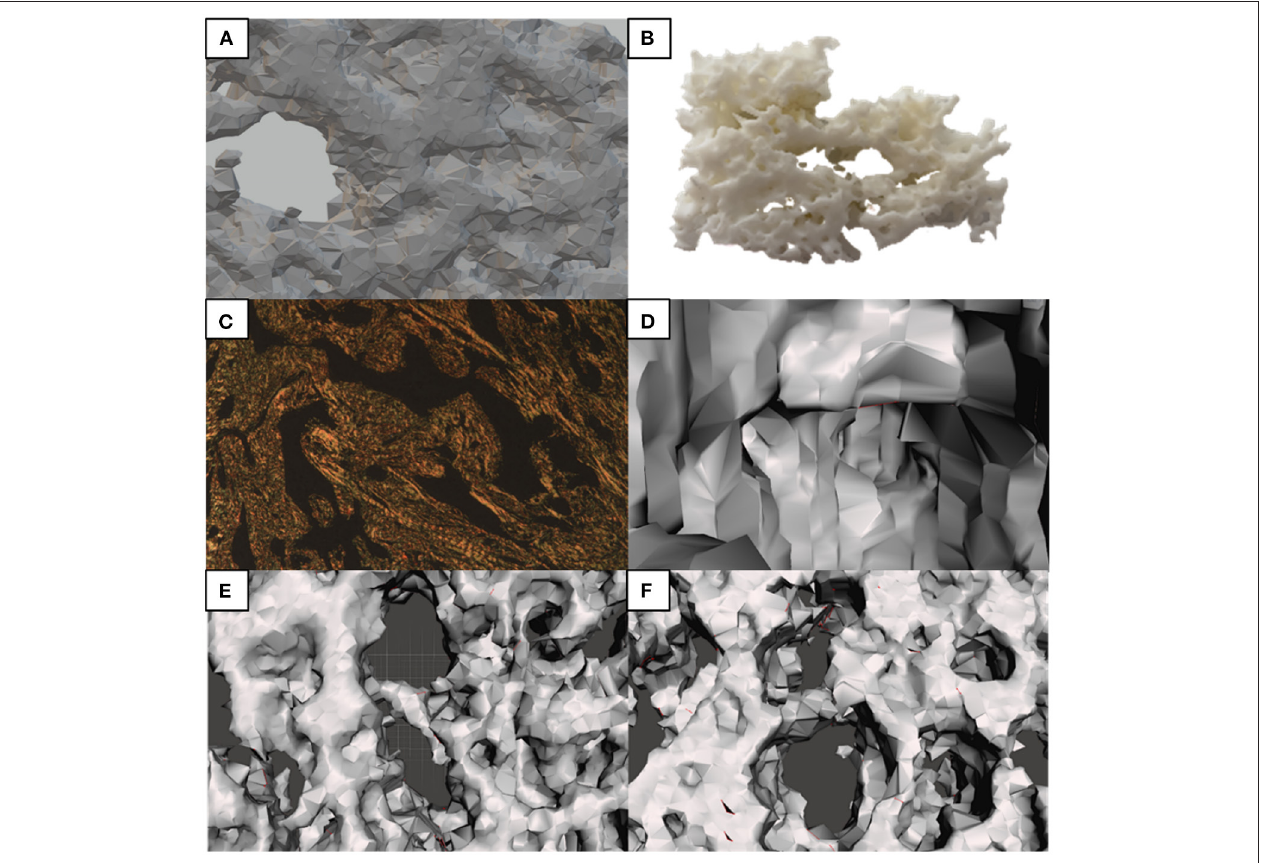
FIGURE 4 | Morphological characteristics observed under conventional microscopy and identified in the 3D model. (A) Simplified 3D model; (B) 3D printed model; (C) 2D microphotography–Picrosirius; (D) Features in the 3D model, such as the communicating channels pointed; (E,F) are the equivalent of the thick central septa of (C) , seen from different angles in the 3D